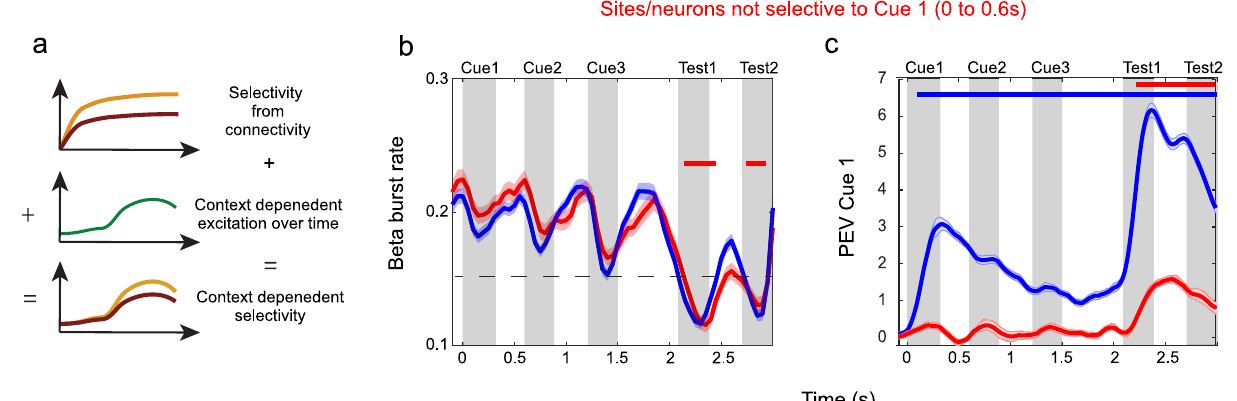
Fig. 6 |Control-related(taskdemand dependent)selectivity arising fromtime- varying excitation. a The conceptual illustration how in the proposed spatial computingframeworkmixedselectivityarisesfromacombinationofitemselectivity (orange vs brown curves, given by network connectivity) and the unique pattern of localexcitation(greencurveshowingthe control-relatedlocalexcitationlevelsover timethatareuniquetoeachcorticallocationandnotdependentontheitemheldin WM). b Beta bursting re fl ects (is anti-correlated with) the excitation in the network. Bluecurves( n =64)correspondtositesinwhichneuronsareselectivetoitemscued atSample 1(measured between0and0.6s),red curves ( n =198)describesiteswith nosuchselectiveneurons.Trialswiththreesequentialsamplecuesandtwotestcues (monkeys correctly respond at Test 2) are shown. Dotted line corresponds to the lowestbetaburstrateforselectivesiteswhennotincludingtheTestperiods.Redbar